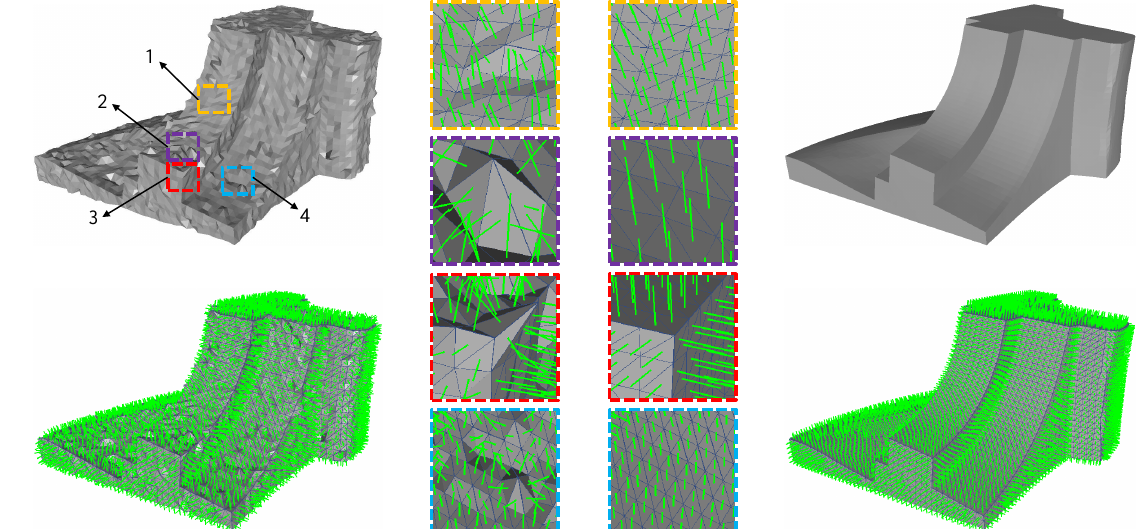
Figure 1. The illustration of effects of the four terms in our normal filtering model. The first column shows the noisy mesh ( top ) and the face normals of it ( bottom ). The second column shows the face normals of four magnified patches of the noisy mesh, while the third column shows the face normals of the corresponding magnified patches of the denoising result. The fourth column shows the denoising result ( top ) and the face normals of it ( bottom